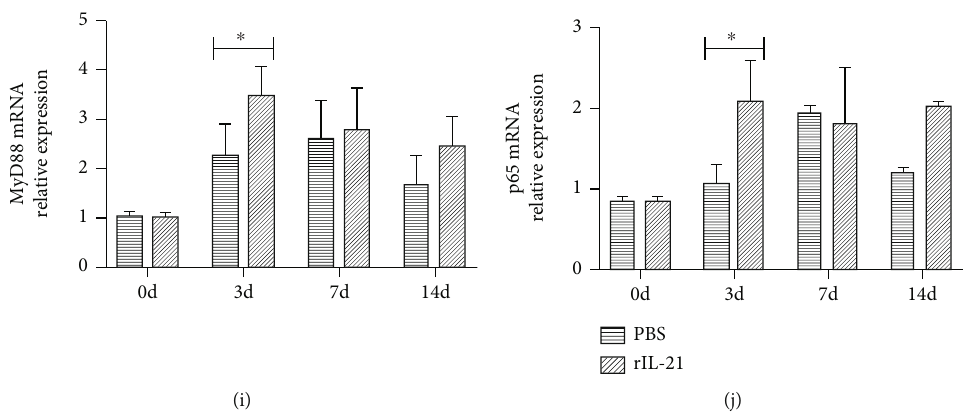
Figure 5: Pulmonary chemokines, cytokines, and TLR/MyD88 signal of recombinant murine IL-21- (rIL-21-) administrated wild-type (WT) mice in response to Chlamydia muridarum ( C. muridarum ) lung infection. The rIL-21 and PBS-treated mice were killed at days 0, 3, 7, and 14 after C. muridarum infection, and total RNA was extracted from the lung tissues to analyze mRNA expression. The quantitative real-time PCR (qPCR) results of chemotactic factors (a – f) KC, MIP-2, CXCR2, IL-6, IL-1 β , and TNF- α as well as TLR/ MyD88 pathway mediators (g – j) TLR2, TLR4, MyD88, and p65 were shown. Data are represented as means ± SD from n = 3 – 4 per group, representative one of three independent experiments. Statistical signi fi cances of di ff erences are determined by two-way ANOVA followed by Bonferroni ’ s multiple comparisons test. ∗ P < 0 : 05 , ∗∗ P < 0 : 01 , ∗∗∗ P < 0 : 001 , and ∗∗∗∗ P < 0 : 0001